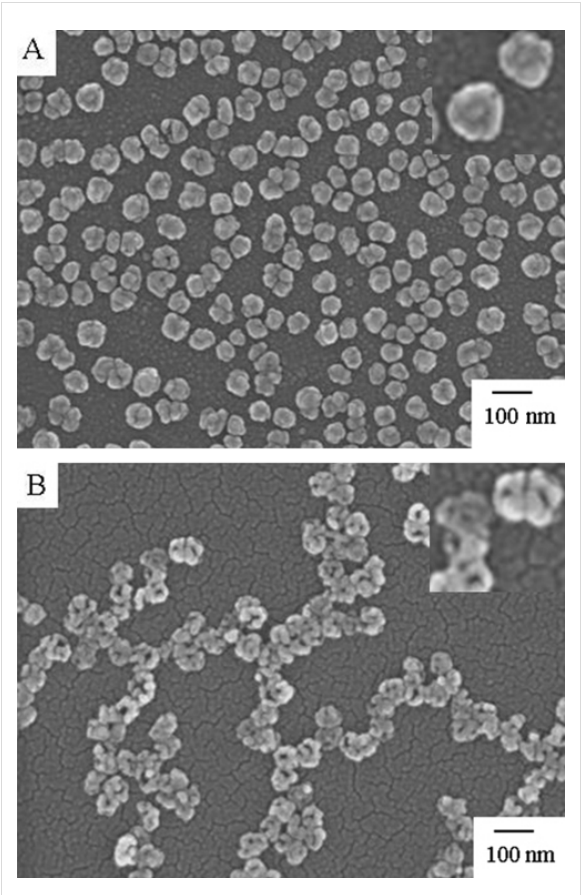
Figure 5: SEM images of Ag–Au NCs treated with 10% H 2 O 2 (A) and 10% HNO 3 (B) for 10 h at room temperature. Insets: the SEM images with higher